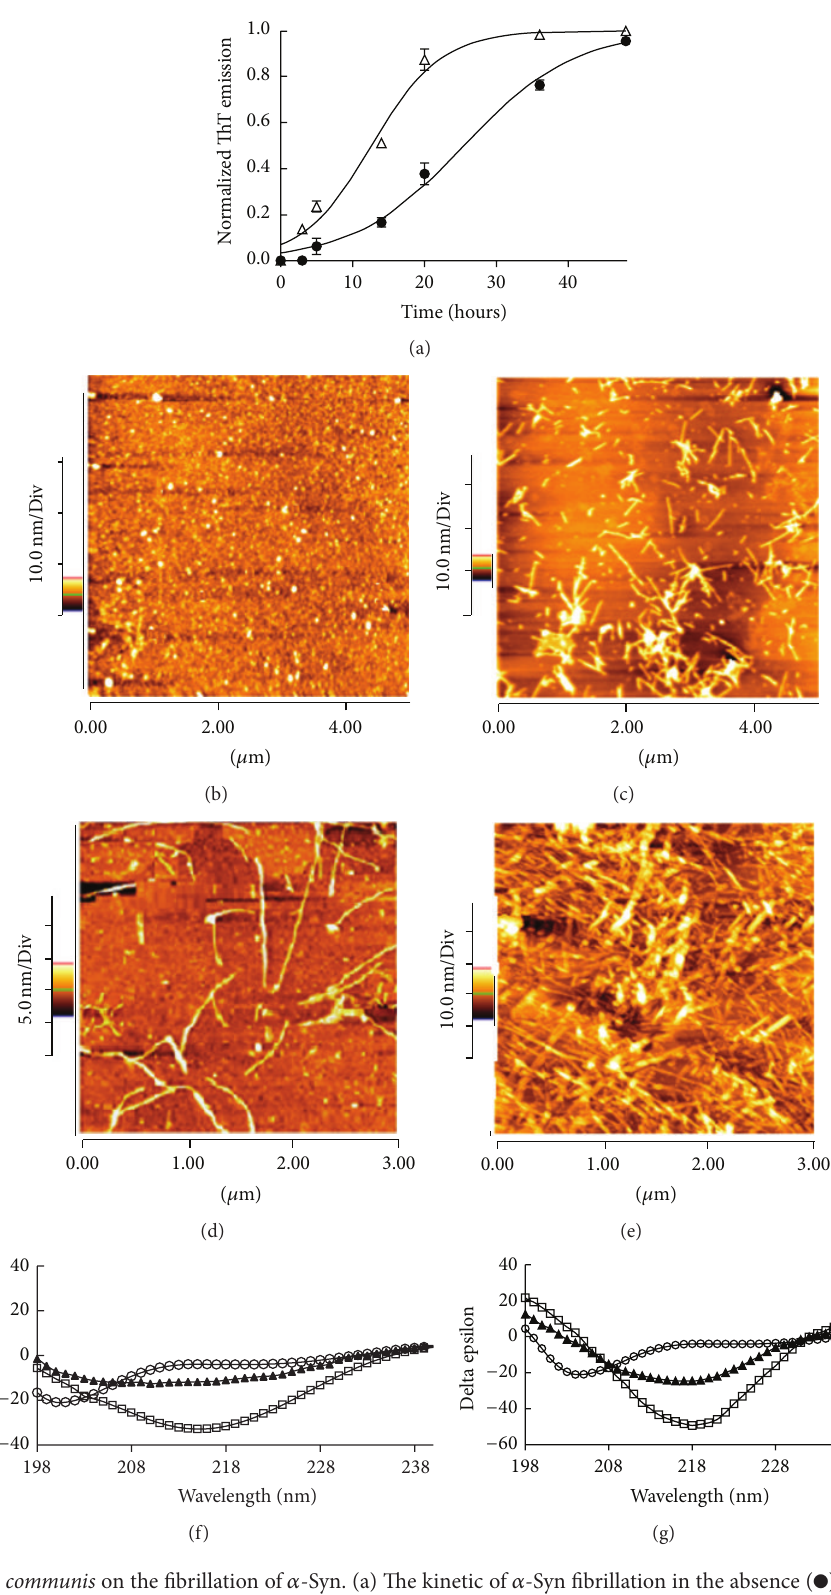
Figure 2: Effect of M. communis on the fibrillation of 𝛼 -Syn. (a) The kinetic of 𝛼 -Syn fibrillation in the absence ( e ) and the presence of 1% of M. communis ( 󳵻 ) monitored by ThT fluorescence. The continuous lines represent fits to (1). (b)–(e) AFM images and (f)-(g) far-UV CD spectra of 𝛼 -Syn incubated without or with M. communis (1%v/v). (b), (c), and (f) are for 𝛼 -Syn incubated without M. communis ; (d), (e), and (g) are for samples incubated with M. communis . ( 󳵳 ) is considered for 7h and ( ◻ ) for 24 h incubation. ( I ) is reflected for fresh monomer protein. The concentration of 𝛼 -Syn was 70 𝜇